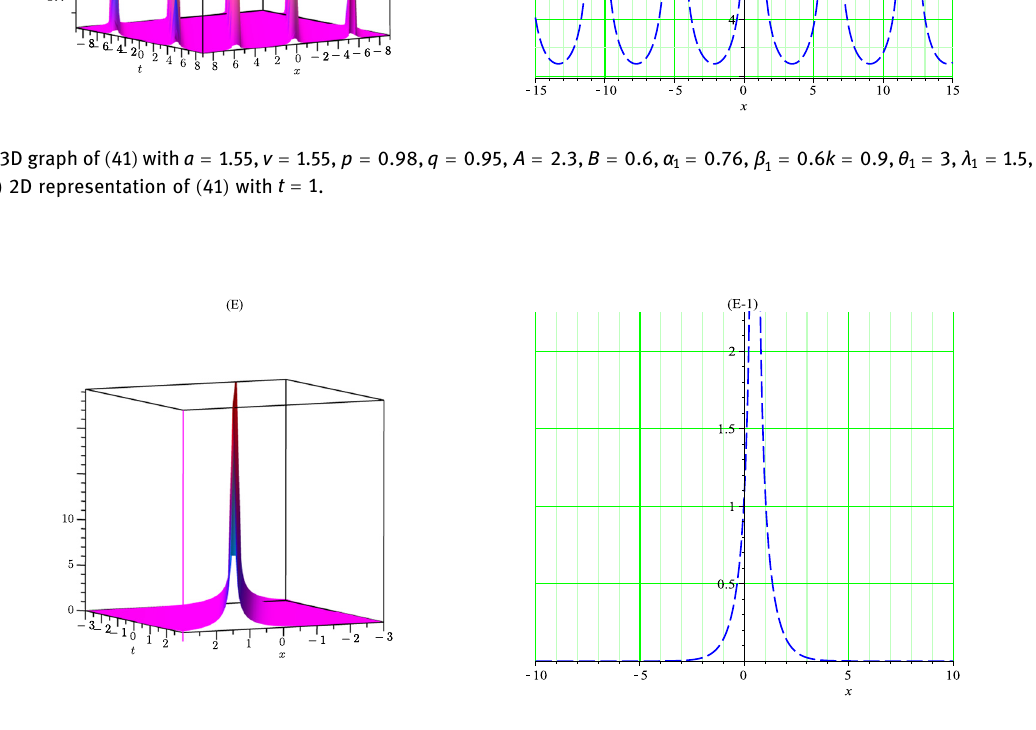
Figure 5: ( E ) 3D graph of ( 67 ) with a . ( E - 1 ) 2D representation of ( 66 ) with t 1 =